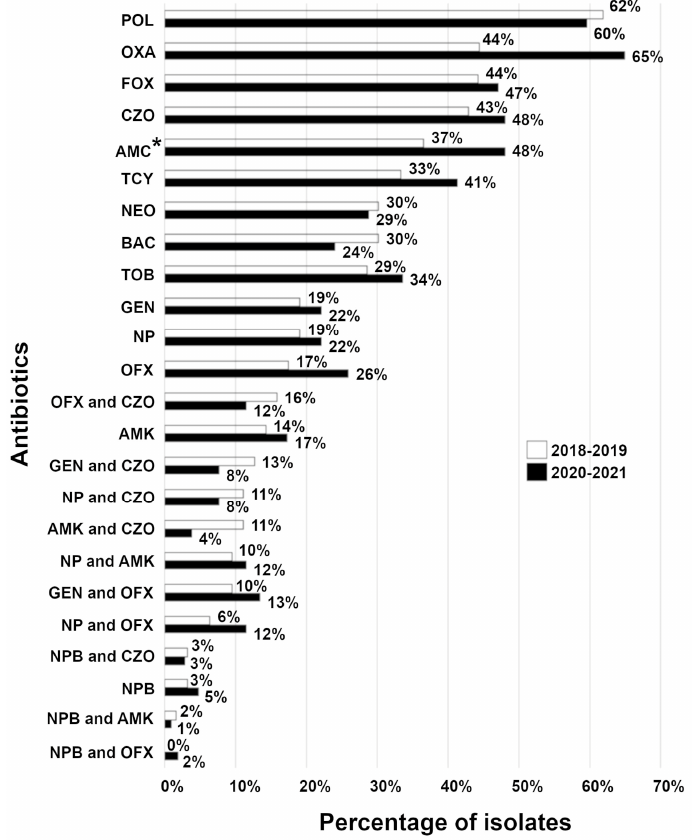
Figure 1. Percentage of total resistant isolates to a single or combination antibiotics from 2018–2019 and 2020–2021. Percentage (%) of overall resistant bacterial species isolated from patients with corneal stromal ulcers (combined intrinsic and acquired resistance). For the period 2018–2019, the number of isolates is 63 for each antibiotic/antibiotic combination except for oxacillin, which numbered 9. For the period 2020–2021, the number of isolates is 104 for each antibiotic/antibiotic combination except for oxacillin, which numbered 20. * = although amoxicillin/clavulanic acid is not used topically, data for this antibiotic are presented here since it is often used postoperatively as a systemic antibiotic. Abbreviations: AMC, amoxicillin/clavulanic acid; AMK, amikacin; BAC, bacitracin; CZO, cefazolin; FOX, cefoxitin; GEN, gentamicin; NEO, neomycin; NP, neomycin and polymyxin B; NPB, neomycin, polymyxin B, and bacitracin; OFX, ofloxacin; OXA, oxacillin; POL, polymyxin B; TCY, tetracycline; TOB,